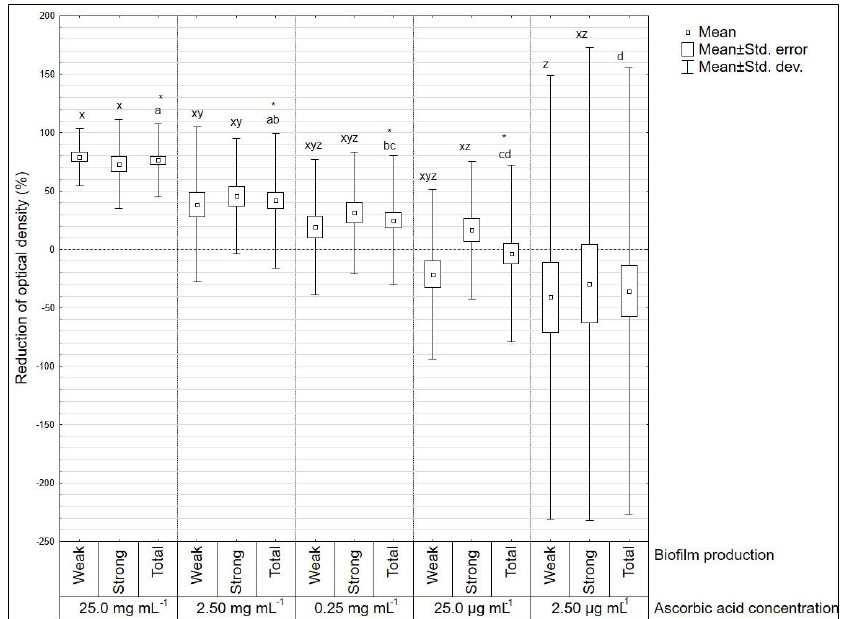
Figure 2. Reduction of optical density (%) after ascorbic acid treatment on Listeria monocytogenes ( n = 19) strains. Amongst all strains n = 10 were defined as weak biofilm producers and n = 9 as strong biofilm producers. Letters a, b, c, d mark statistically significant differences between different concentrations (all strains included). Letters x, y, z mark statistically significant differences between groups of strong and weak biofilm producers ( p < 0.05). * Statistically significant difference between certain ascorbic acid concentration and positive control (marked with horizontal line, value “0” on y axis). Microorganisms 2020 , 8 , 553